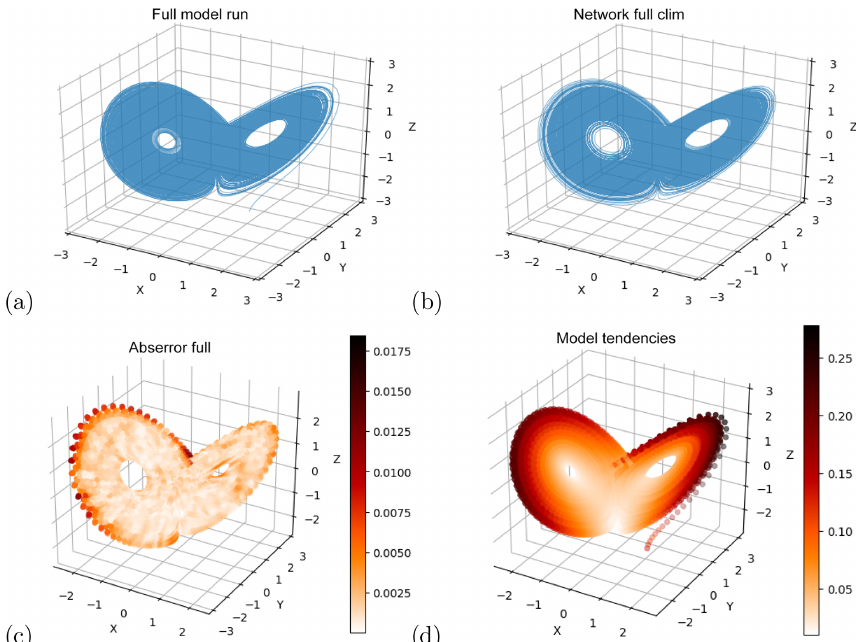
Figure 1. (a) A long integration of the Lorenz63 model. (b) Time series produced with a neural network optimized on short-term forecast error, initialized from a random initial state not used in the training. (c) Short-term forecast errors of the neural network initialized at a large number of points not used for training. (d) Tendencies for one time step ( t i + 1 − ti ). Note the different color scales in (c) and (d)